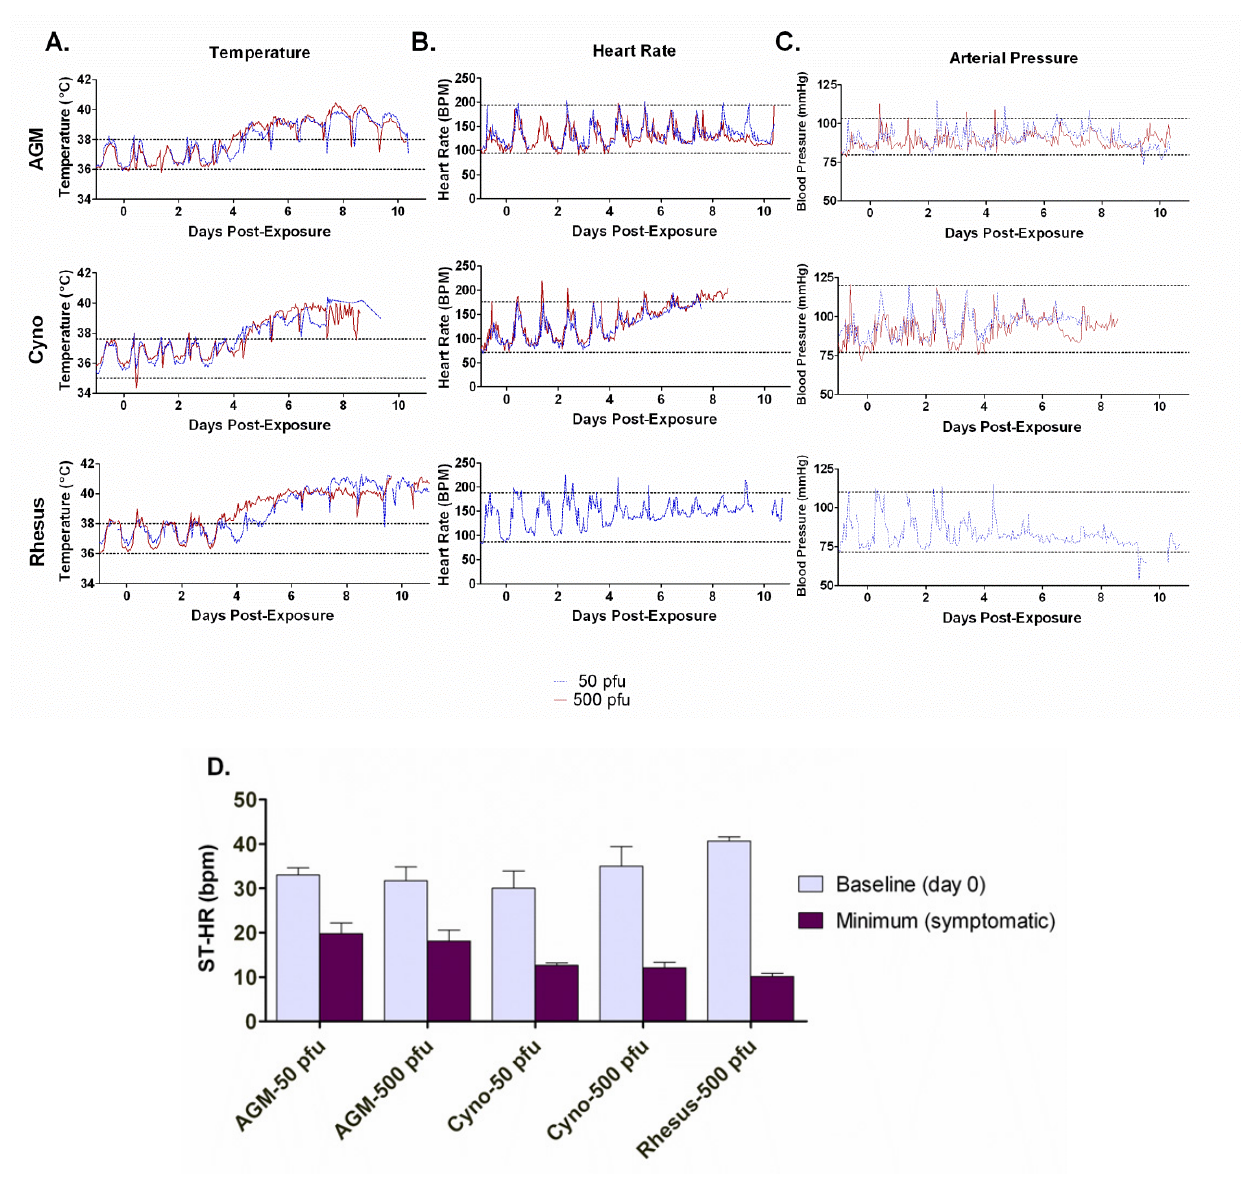
Figure 2 . Telemetry: Temperature, Heart Rate, Arterial Pressure. A ) Temperature, B ) heart rate and C ) pressure were measured by internally implanted telemetry devices once every hour throughout the study in NHPs exposed to two different doses of aerosolized SUDV. There were six animals per group. The values shown represent the average for each group. The straight dashed lines indicate the baseline maximum and minimum average diurnal values before exposure. D ) The standard deviation of the heart rate (SD-HR) was calculated, expressed as beats per minute (bpm). For all species and doses examined, the SD-HR decreased significantly post-exposure, suggesting a loss of the diurnal rhythm ( p <0.01). Telemetry was not calculated for the rhesus 50 pfu group due to equipment